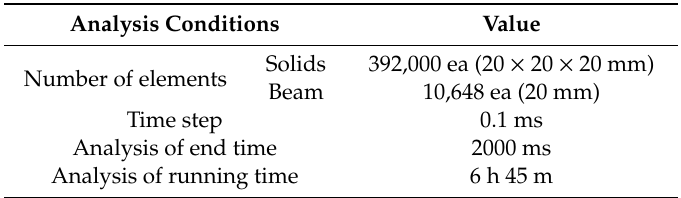
Table 4. Analysis